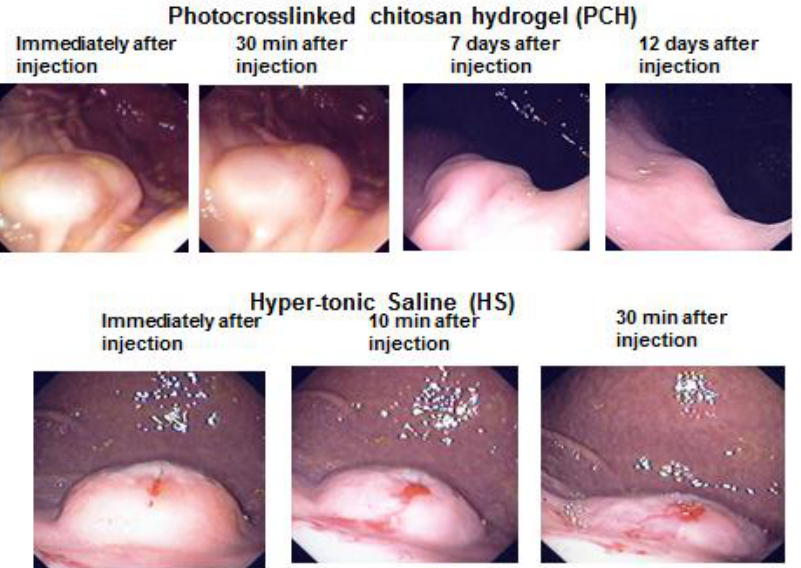
Figure 3. Endoscopic appearance at injection sites of PCH or HS. The change of each injection site was observed endoscopically, without dissection, at the indicated time points. Reprinted from [5], Copyright 2009, with permission from Thieme.